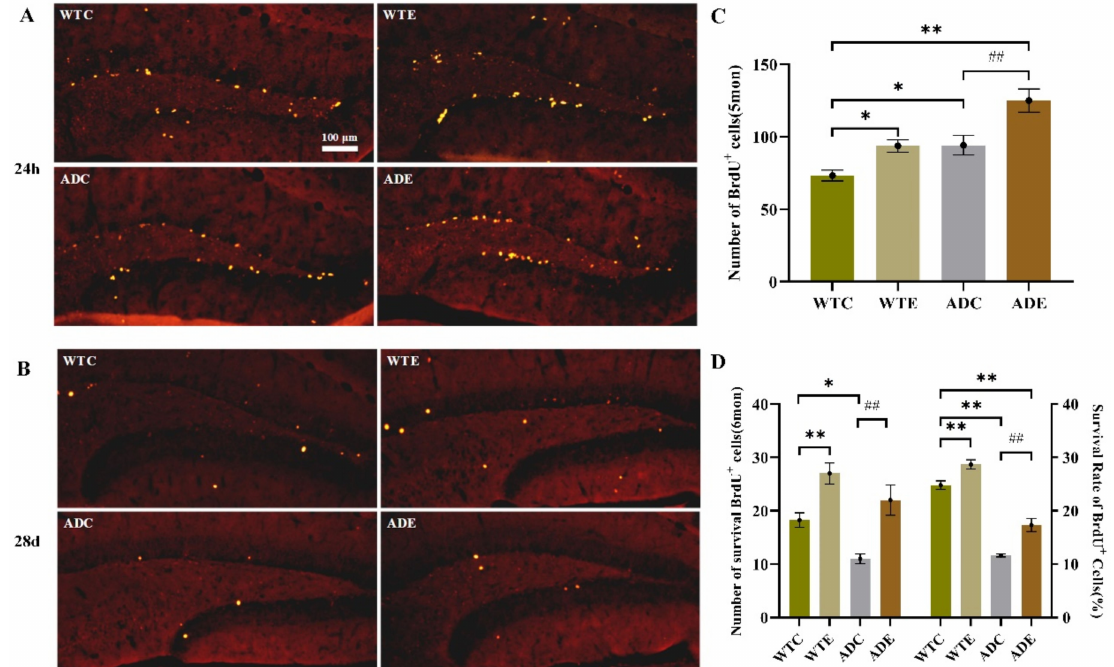
Figure 4. Effect of treadmill exercise on the survival of new cells in mice. ( A ) Fluorescence staining images of BrdU-positive cells in 5-month-old mice 24 h after BrdU injection. ( B ) Fluorescence staining images of BrdU-positive cells in 6-month-old mice 28 days after BrdU injection. ( C ) Number of cells that had survived in 5-month-old mice 24 h after BrdU injection. ( D ) Number of cells that had survived in 6-month-old mice 28 days after BrdU injection (left); Survival rate of cells in 5-month-old mice 28 days after BrdU injection (right). n = 4 for each group. * p < 0.05, ** p < 0.01 compared with WTC. ## p < 0.01 compared with